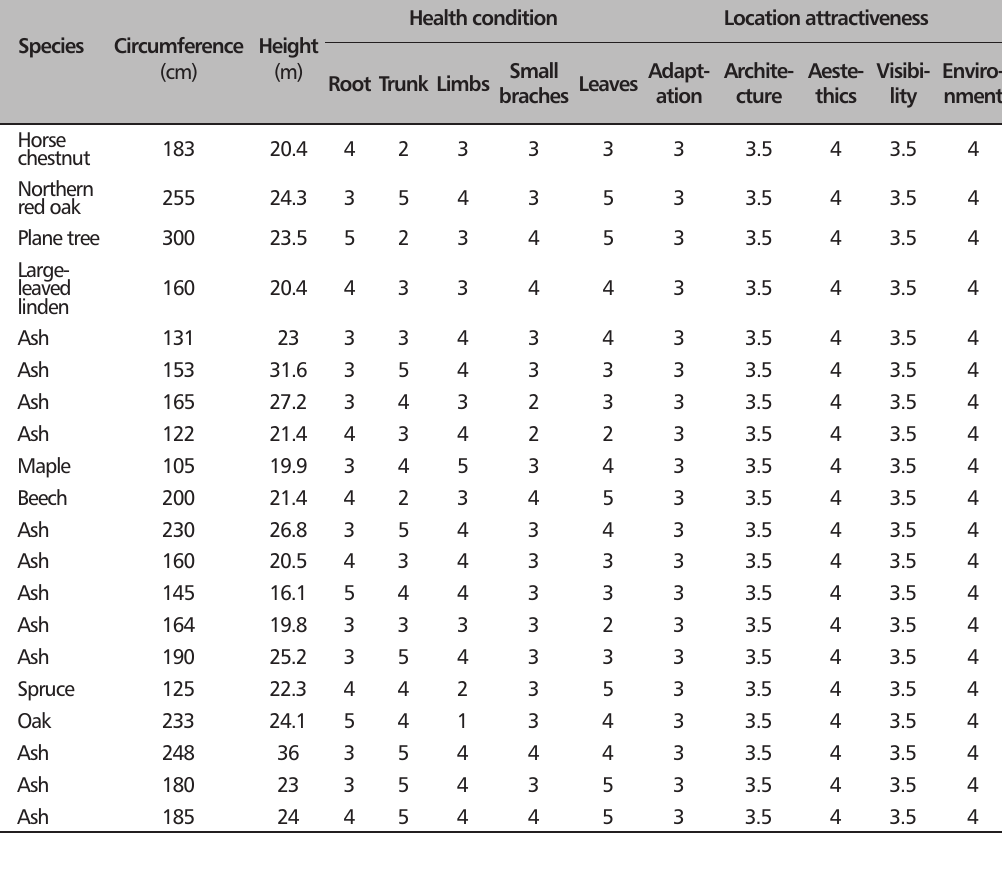
TABLE 2. Dimensions of trees and the aesthetic features assessment